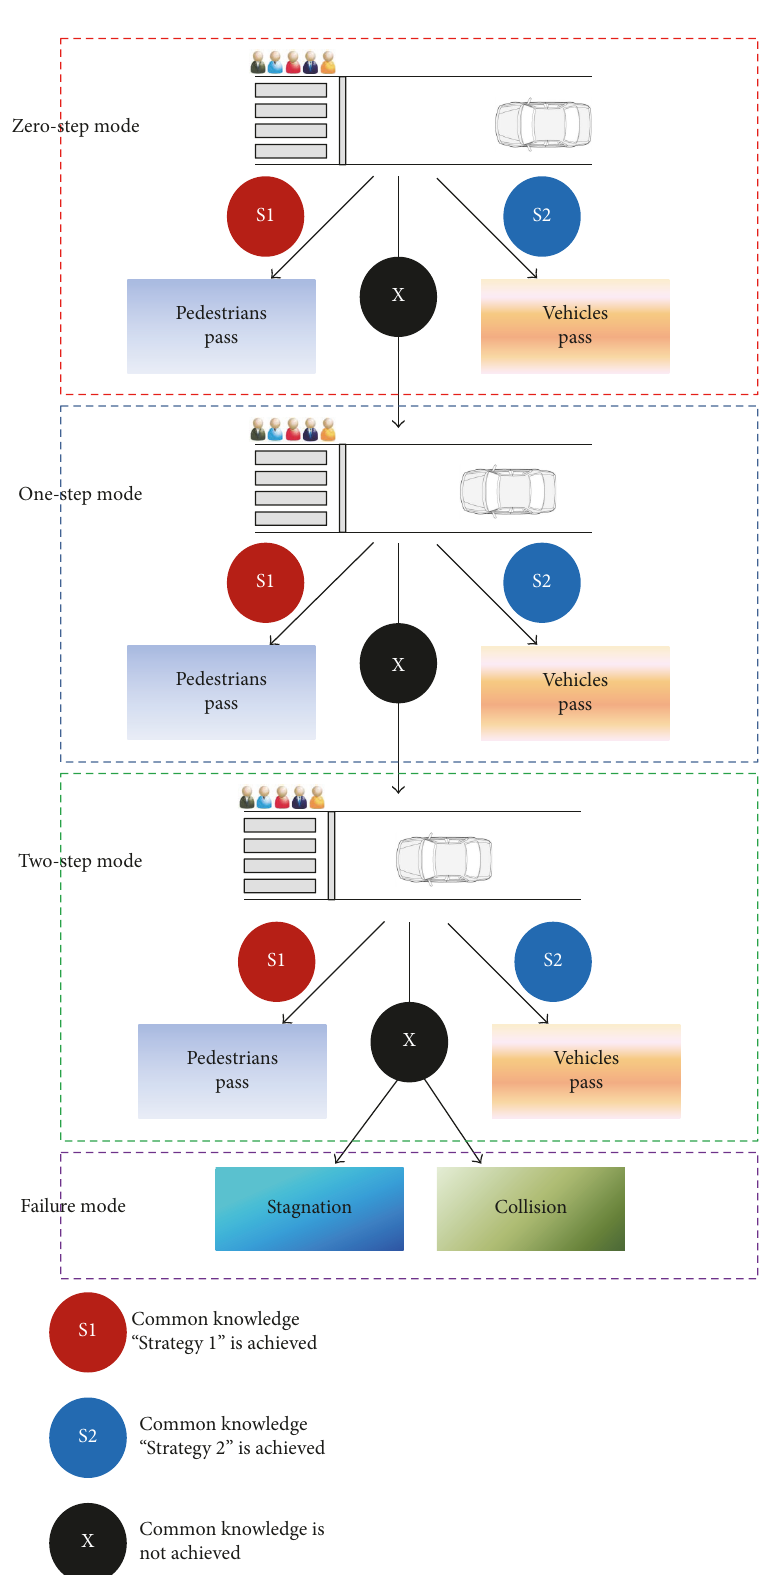
Figure 1: Schematic diagram to illustrate the multidimensional dirty faces game of pedestrian group-crossing